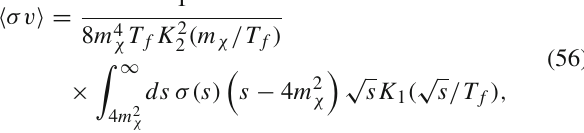
where (cid:24) χ h 2 = 0 . 120 ± 0 . 001 [34]. Here, g (cid:25) S ( T f )